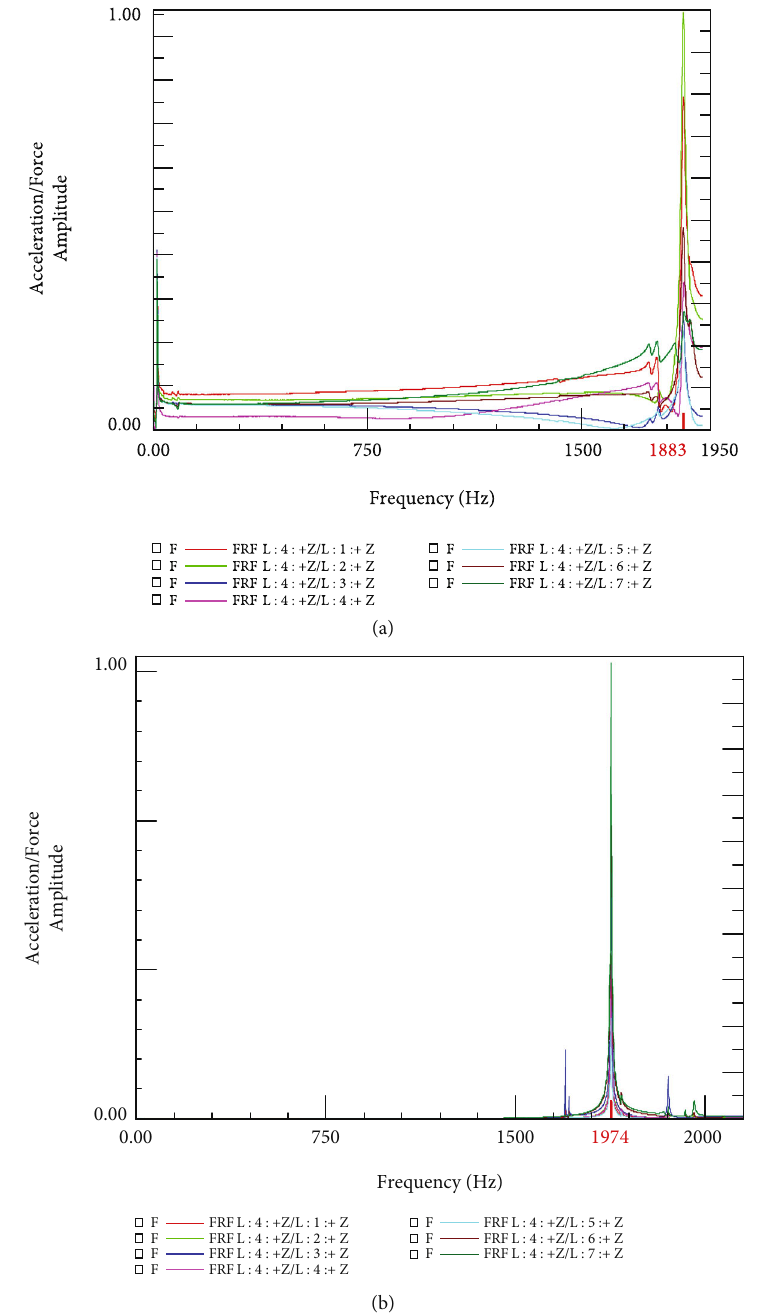
Figure 10: Acceleration FRFs of 7 excitation points for the HSTs: (a) steel – CFRP – steel sandwich walls and (b) steel